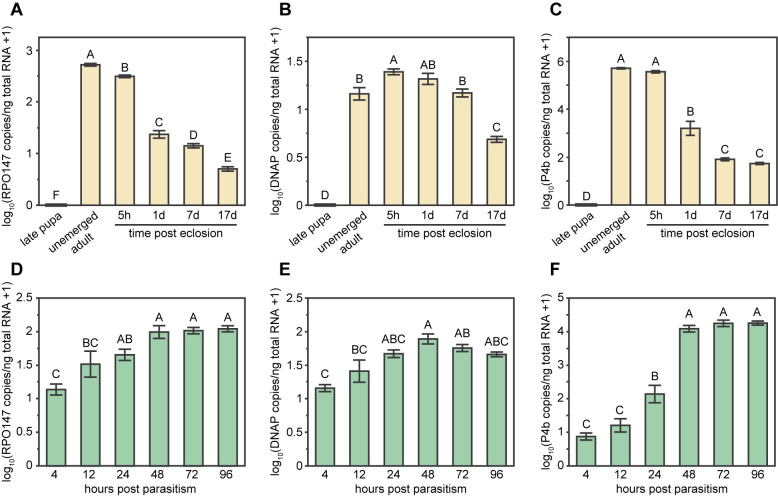
DlEPV gene expression profiles for selection of RNA-seq timepoints.Expression of DlEPV genes measured with RT-qPCR in (A-C) female wasp venom glands from late pupa to 17-day-old adult and (D-F) parasitized flies from 4–96 hours post parasitism (hpp). Profiled DlEPV genes encode (A,D) the 147kDa RNA polymerase subunit RPO147, (B,E) the DNA polymerase DNAP, and (C,F) the structural protein P4b. Each bar represents the mean log10 transformed cDNA copy number per ng total RNA averaged from 6 biological replicates. Error bars represent one standard error above and below the mean, and the letter(s) above each bar indicates statistically distinct mean values from Tukey’s HSD tests. Data in (A-C) were modified from Coffman et al. 2020 [34].